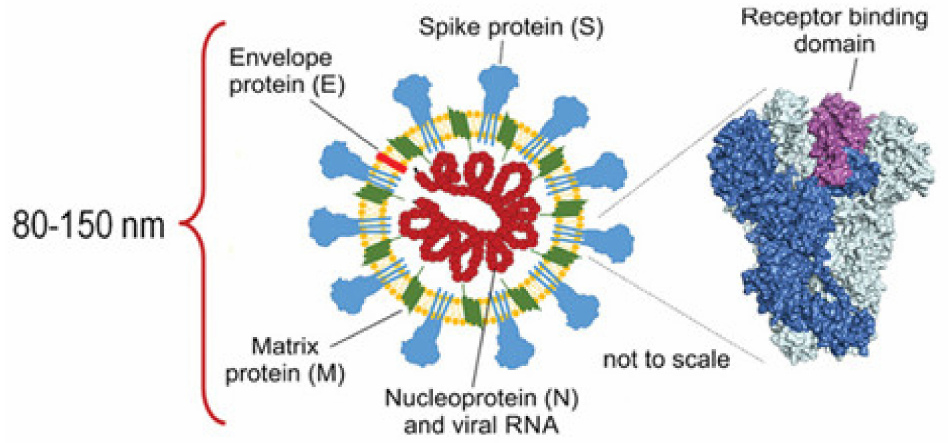
Figure 2. Coronavirus disease (COVID-19) (adapted with permission from Reference